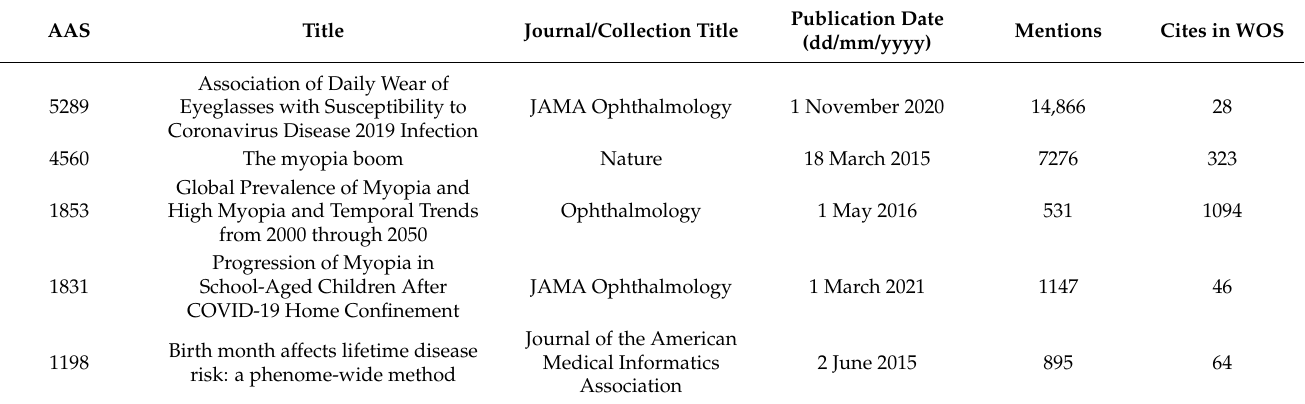
Table 6. Top-5 research outputs about myopia according to the Altimetric Attention Score